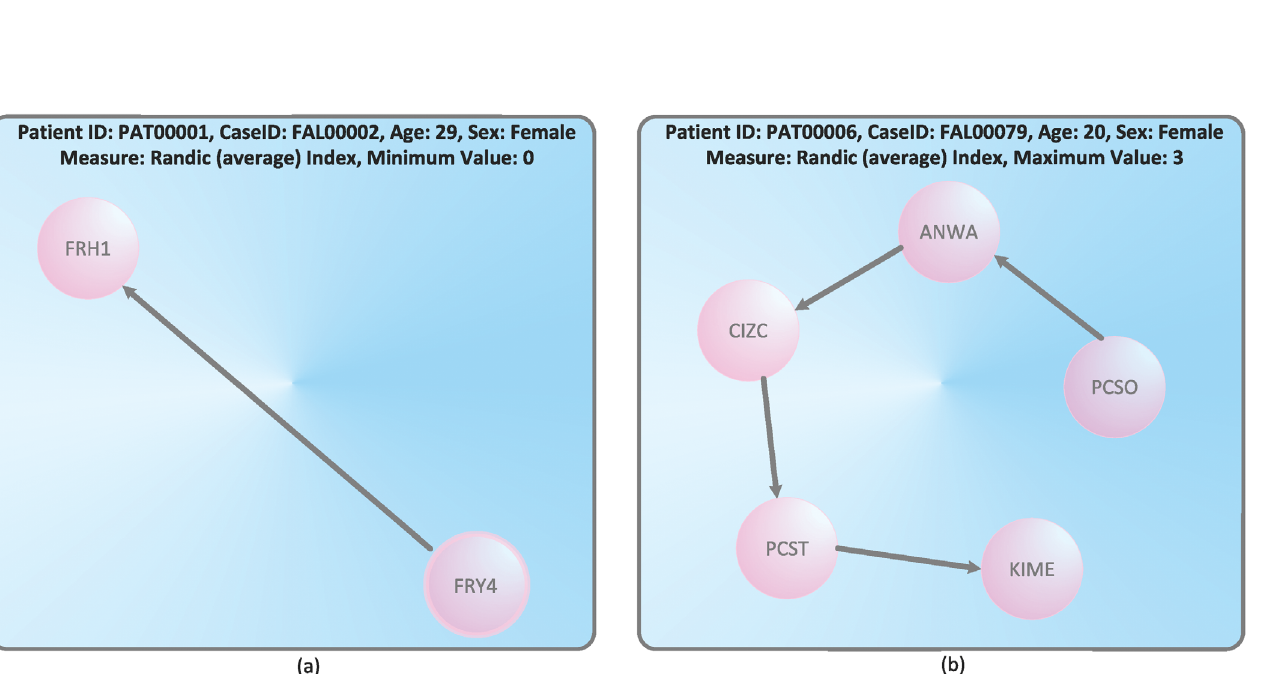
Fig 7. Treatment cycles with the minimal and maximal Randi ć index.